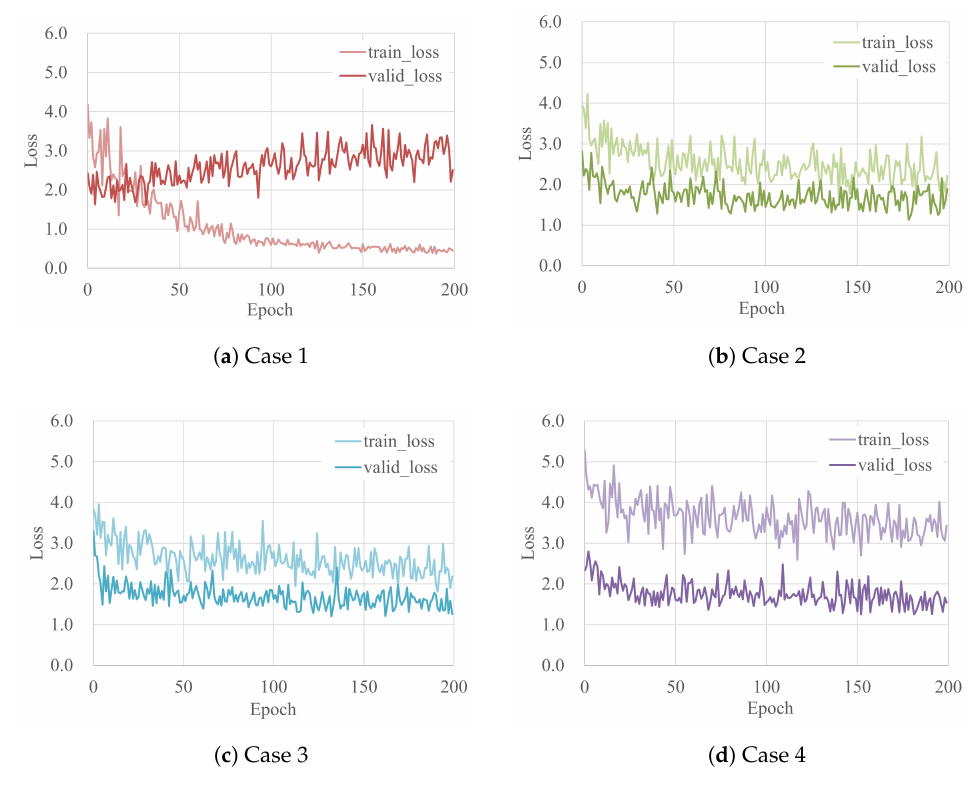
Figure 3. Training and validation loss in each